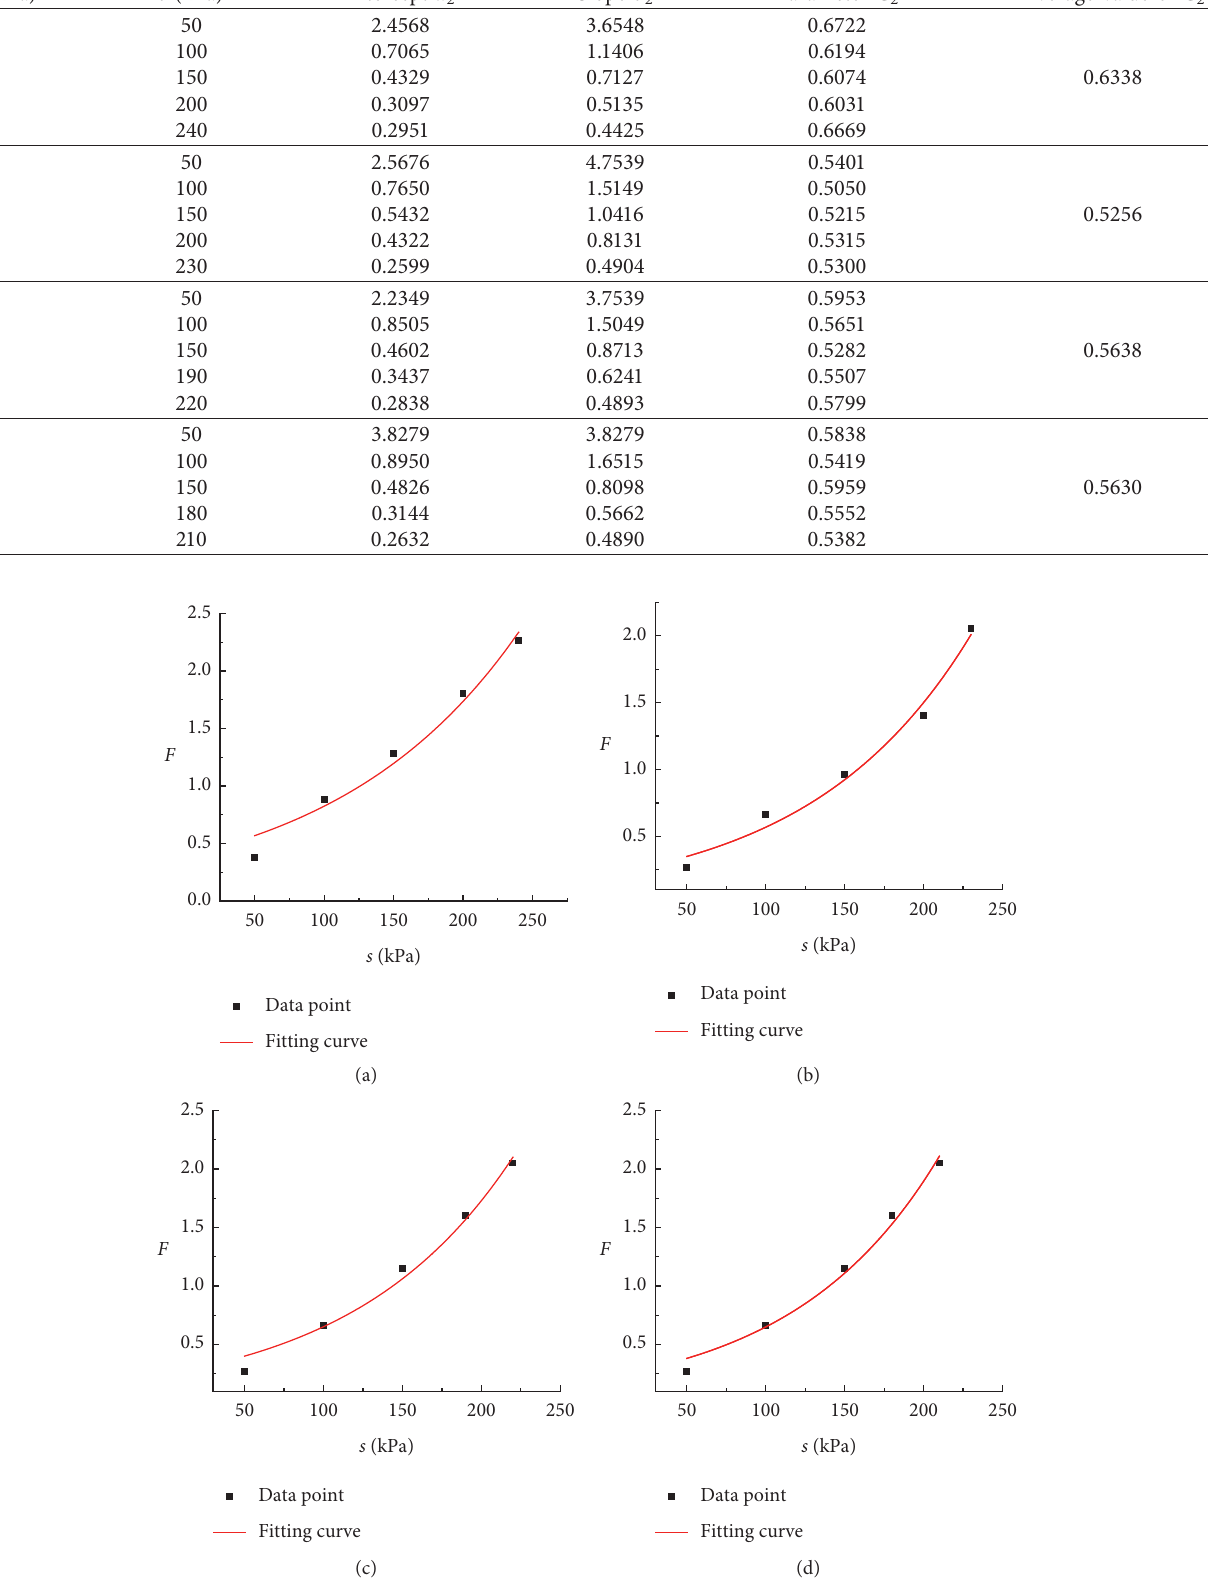
Table 8: Parameters of n � 3 under different initial static deviatoric stress.